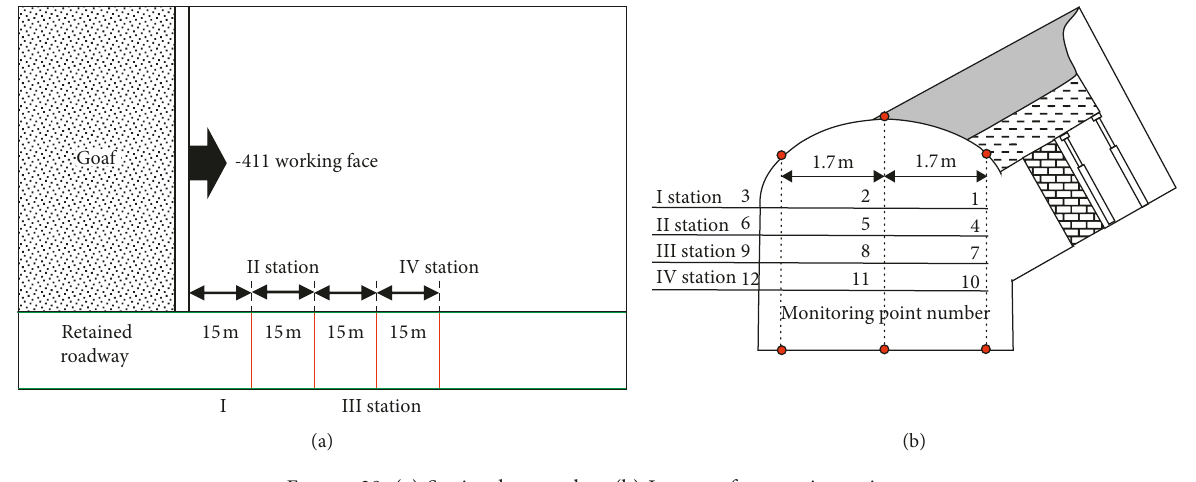
Figure 28: (a) Station layout plan. (b) Layout of measuring points.